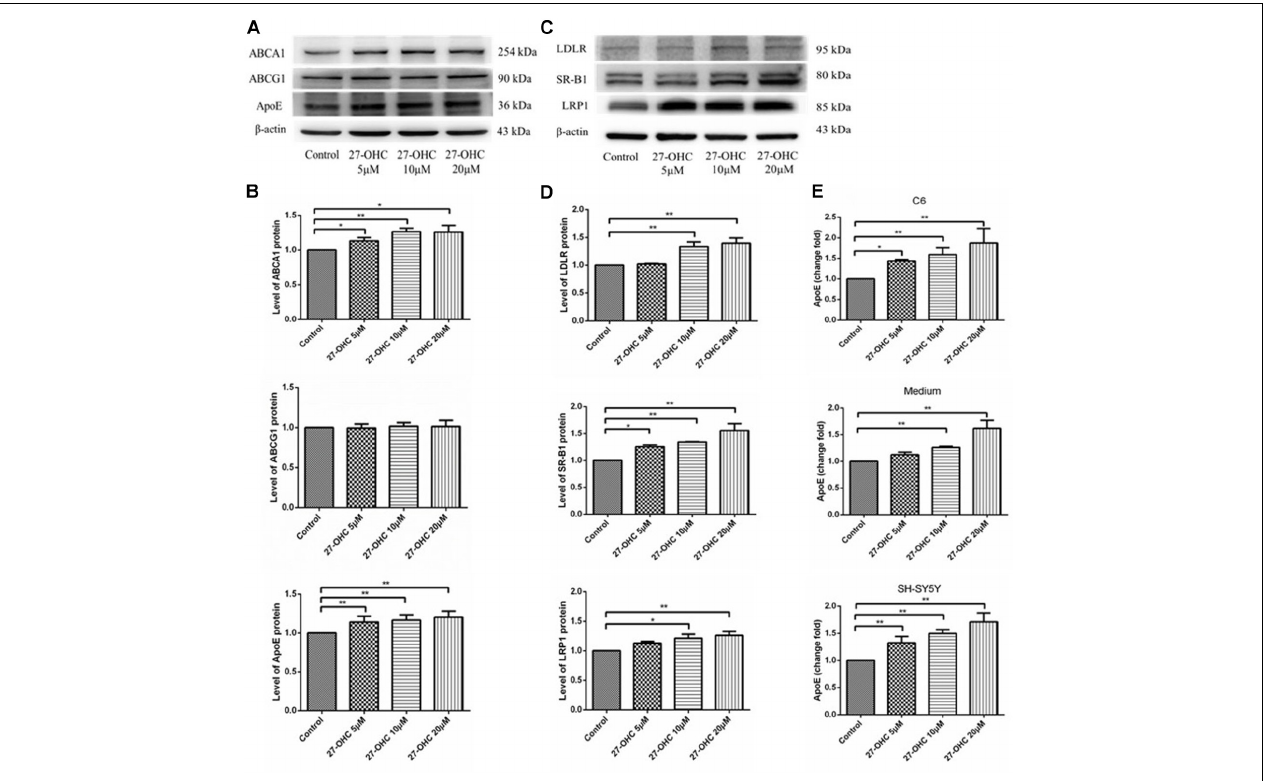
FIGURE 3 | Cholesterol transport in C6 cells and SH-SY5Y cells. (A,B) Western blot analysis of ABCA1, ABCG1, and ApoE in C6 cells with 0, 5, 10, and 20 µ M 27-OHC for 24 h. (C,D) Western blot analysis of LDLR, SR-B1, and LRP1 in SH-SY5Y cells after 0, 5, 10, and 20 µ M 27-OHC treatment for 24 h. (E) ApoE content in C6 cell pellets, medium, and SH-SY5Y cell pellets using ELISA. Densitometric analysis was normalized with the β -actin blots. * P < 0.05 compared with the control group; ** P < 0.01 compared with the control group (one-way ANOVA).